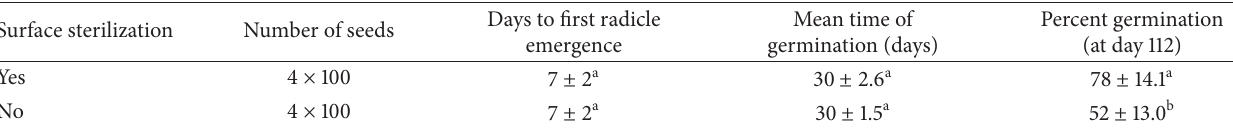
Table 5: The effect of surface sterilization on the germination characteristics of Calluna vulgaris seeds under a photoperiod of 8 h and a temperature regime of 10 ∘ C. Storage duration: 108 days. Mean values ± standard deviations. In each column, groups that showed significant differences ( 𝑃 < 0.05 ) are indicated with different letters.